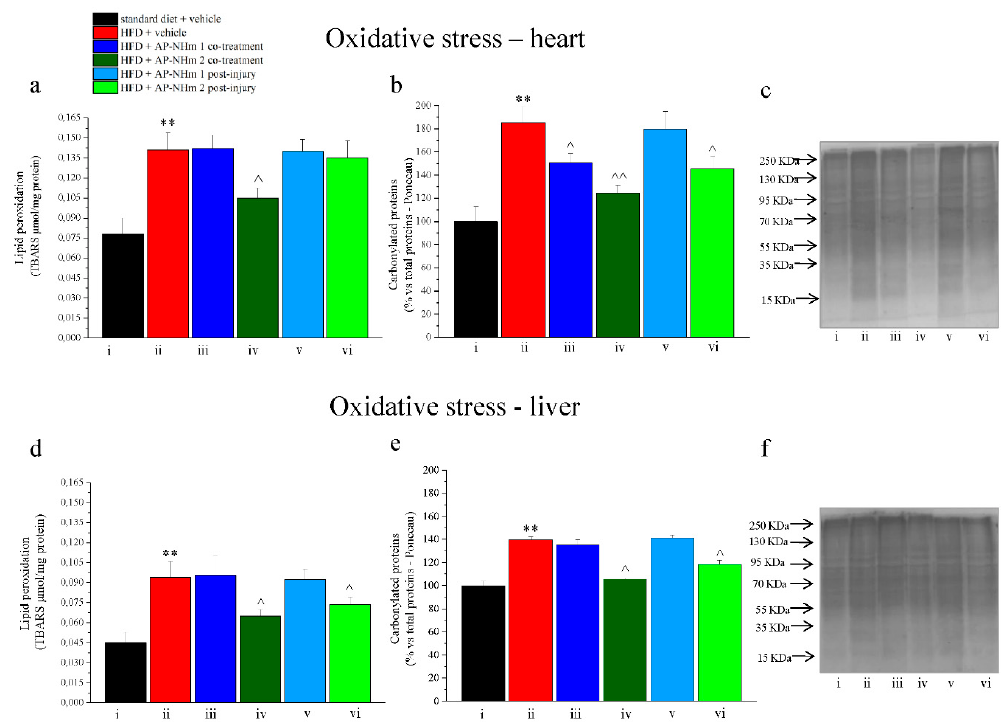
Figure 9. Effects of AP-NHm 1–2, in co-treatment or in post-injury treatment, on oxidative damage